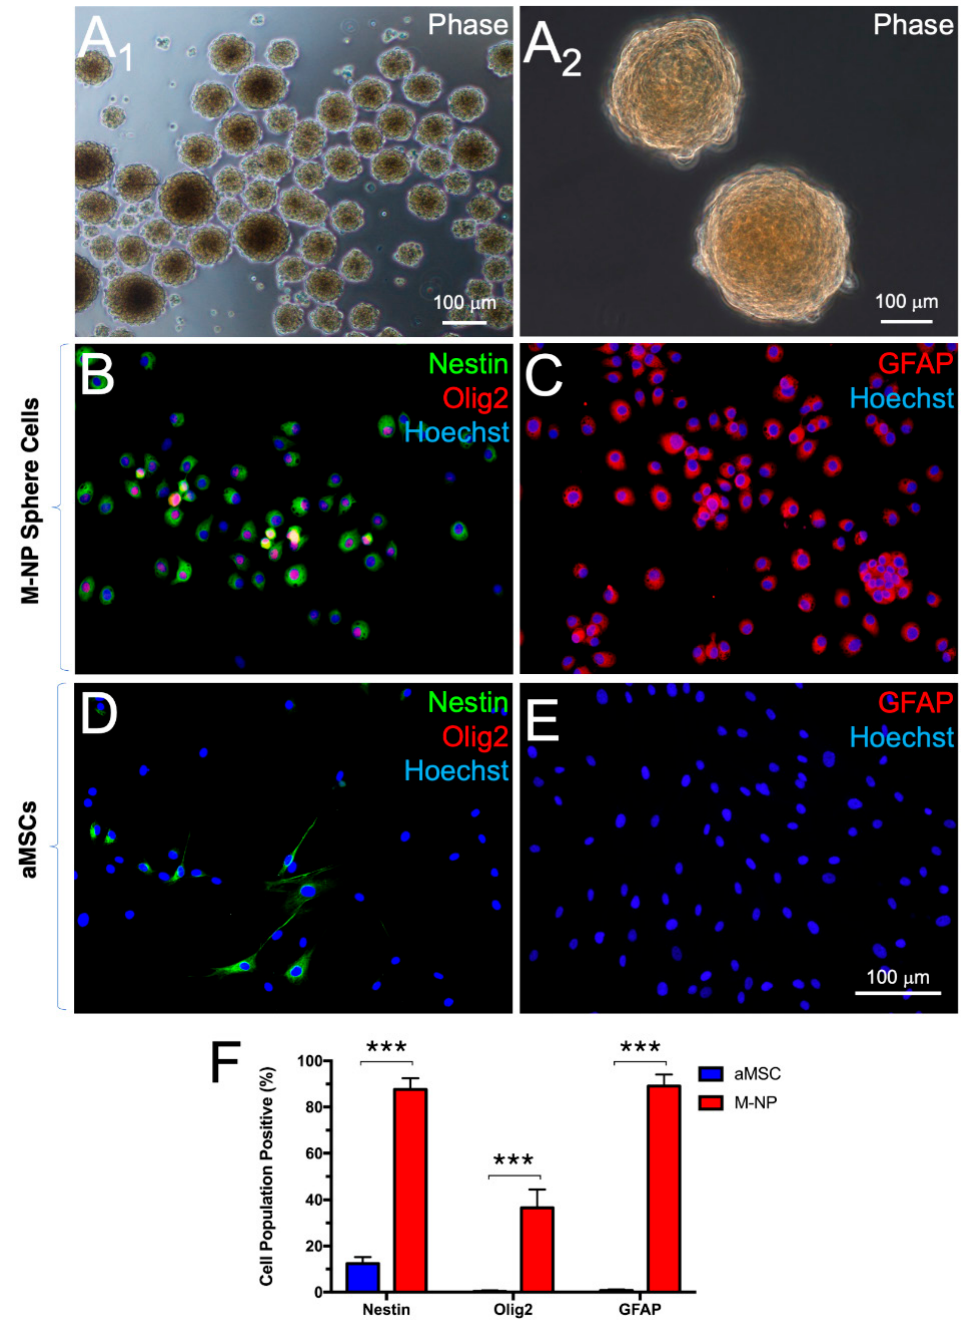
Figure 2. Selective expansion of neural progenitors in non-adherent culture. aMSCs formed spheres by day 6 in non- adherent culture ( A 1,2 ). Increased expression of nestin ( B ), Olig2 ( B ), and GFAP ( C ) were observed in the course of non- were observed in the course of non-adherent culture versus parallel, adherent cultures of aMSCs adherent culture versus parallel, adherent cultures of aMSCs ( D , E ). Histogram showing the percentage of aMSCs positive ( D , E ). Histogram showing the percentage of aMSCs positive for the indicated markers ( F ). n = 5 for the indicated markers ( F ). n = 5 independent preparations. ***: p < 0.0001. Student’s t -test. independent preparations. ***: p < 0.0001. Student’s t